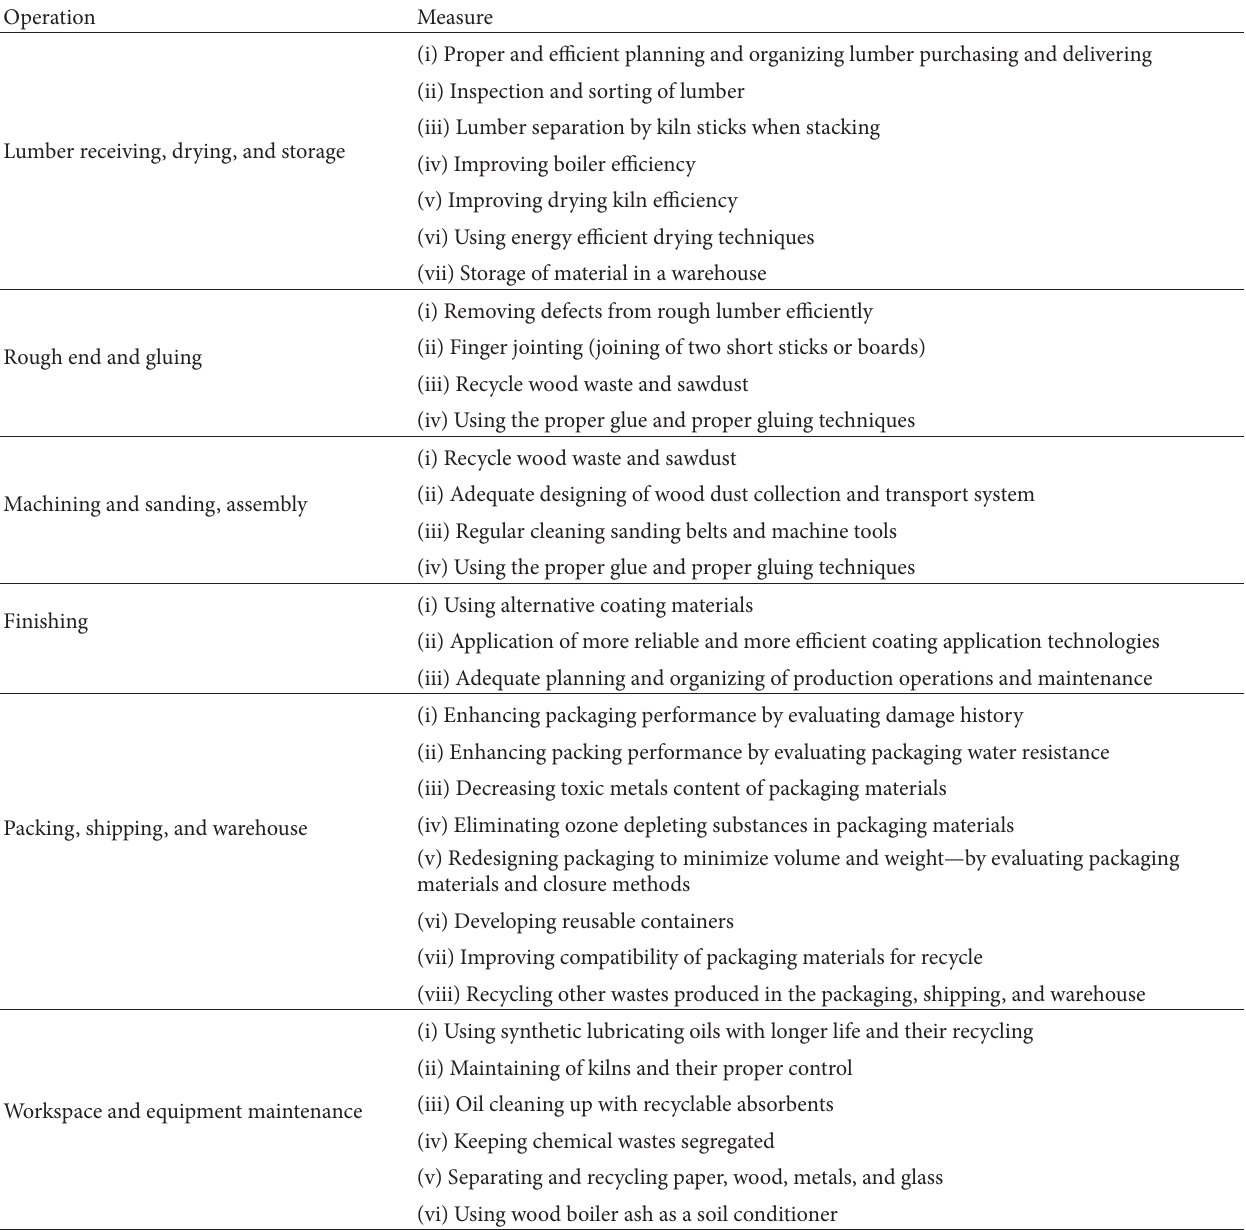
Table 7: Measures for waste reduction in wood furniture industry [27,